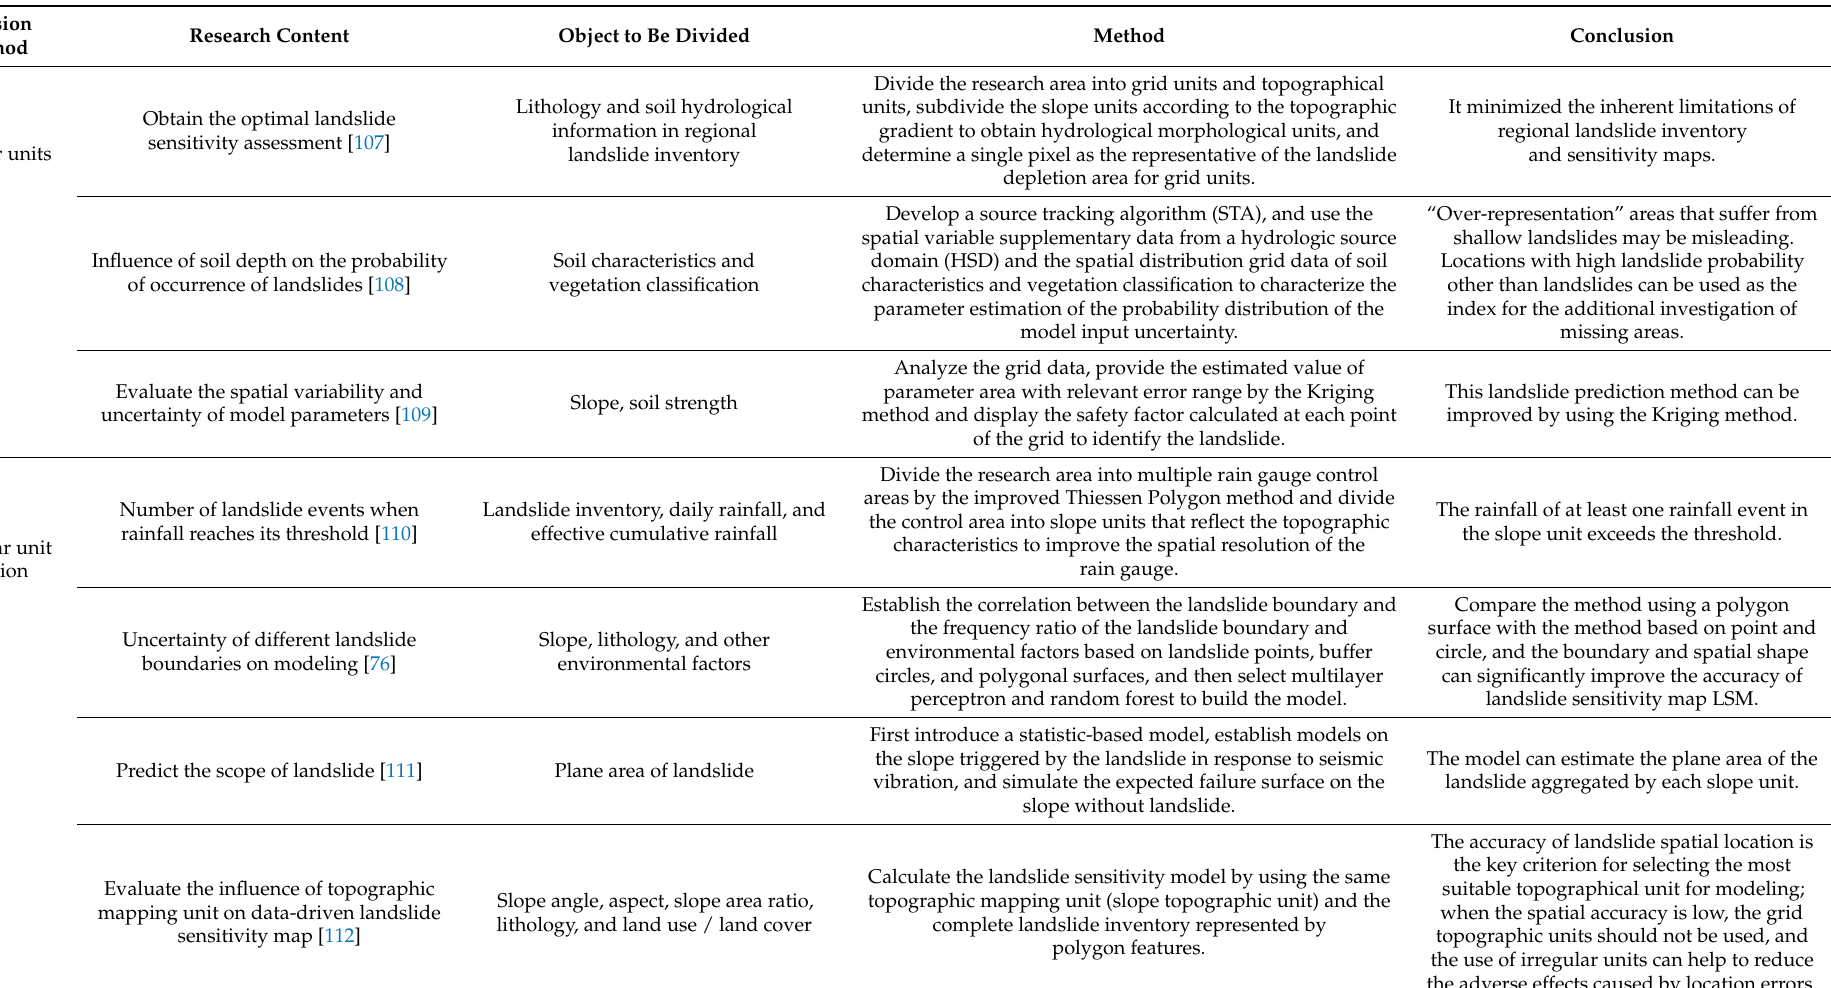
Table 5. Typical cases of nonlinear correlation analysis of disaster-causing